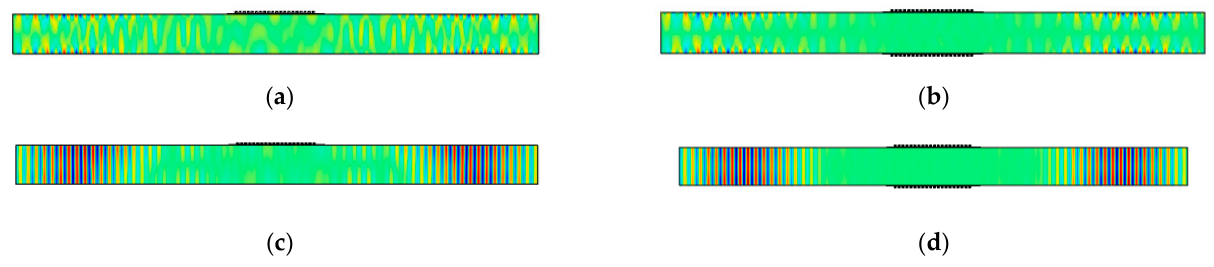
Figure 13. Snapshots at 60 μ s of A0 Lamb wave mode actuation with 447 kHz signal: ( a ) u 1 displacement from single-sided MST; ( b ) u 1 displacement from double-sided MST out-of-phase; ( c ) u 3 displacement from single-sided MST; ( d ) u 3 displace- ment from double-sided MST out-of-phase. The plots are stretched vertically for clarity.